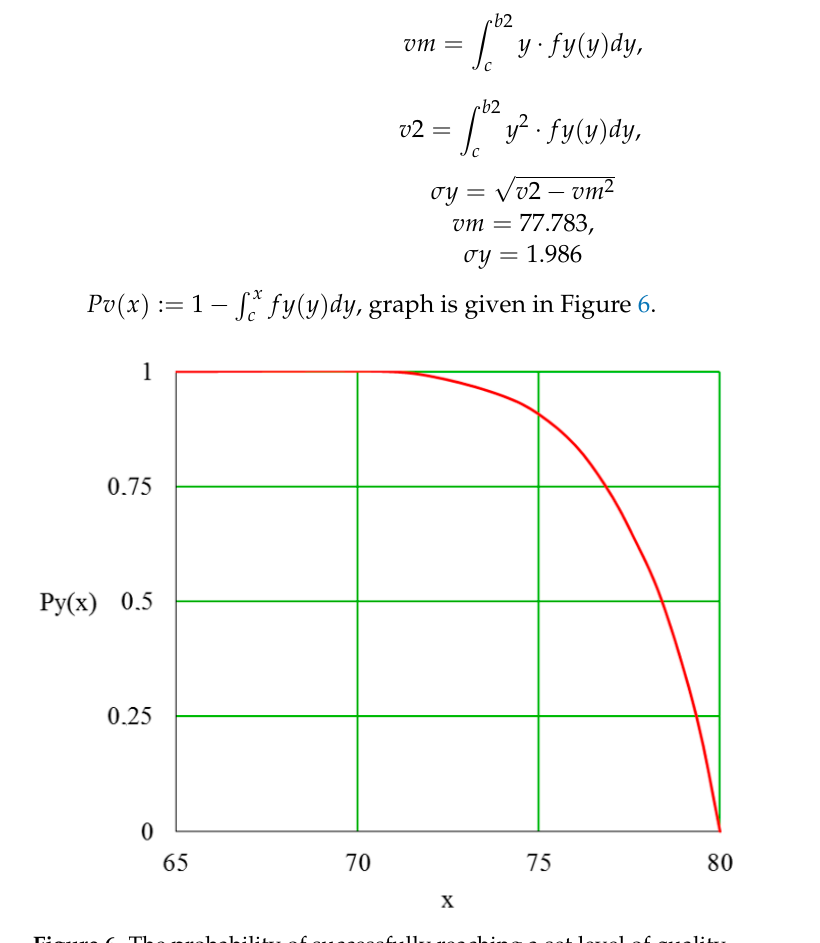
Figure 6. The probability of successfully reaching a set level of quality.